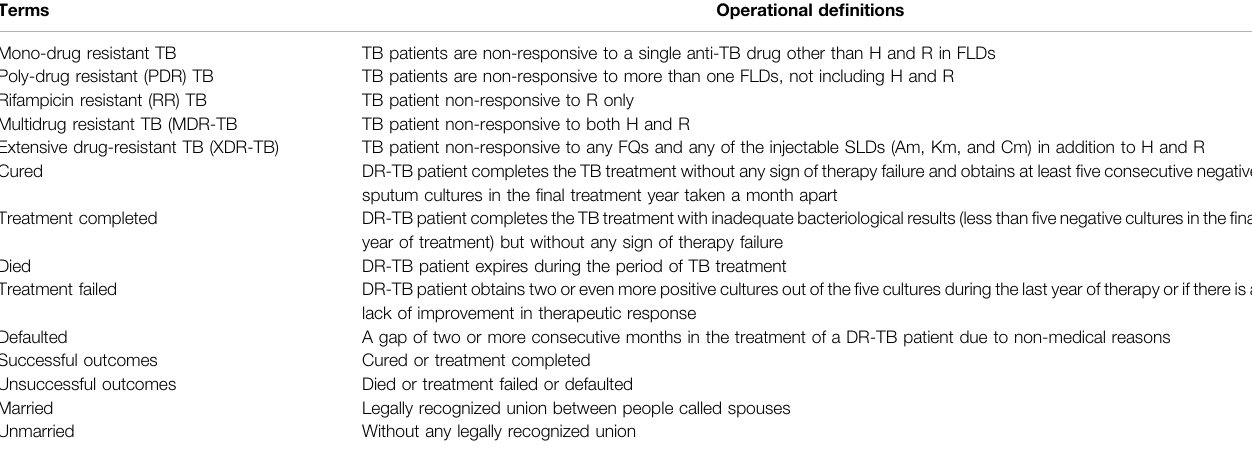
TABLE 1 | Operational de fi nitions.